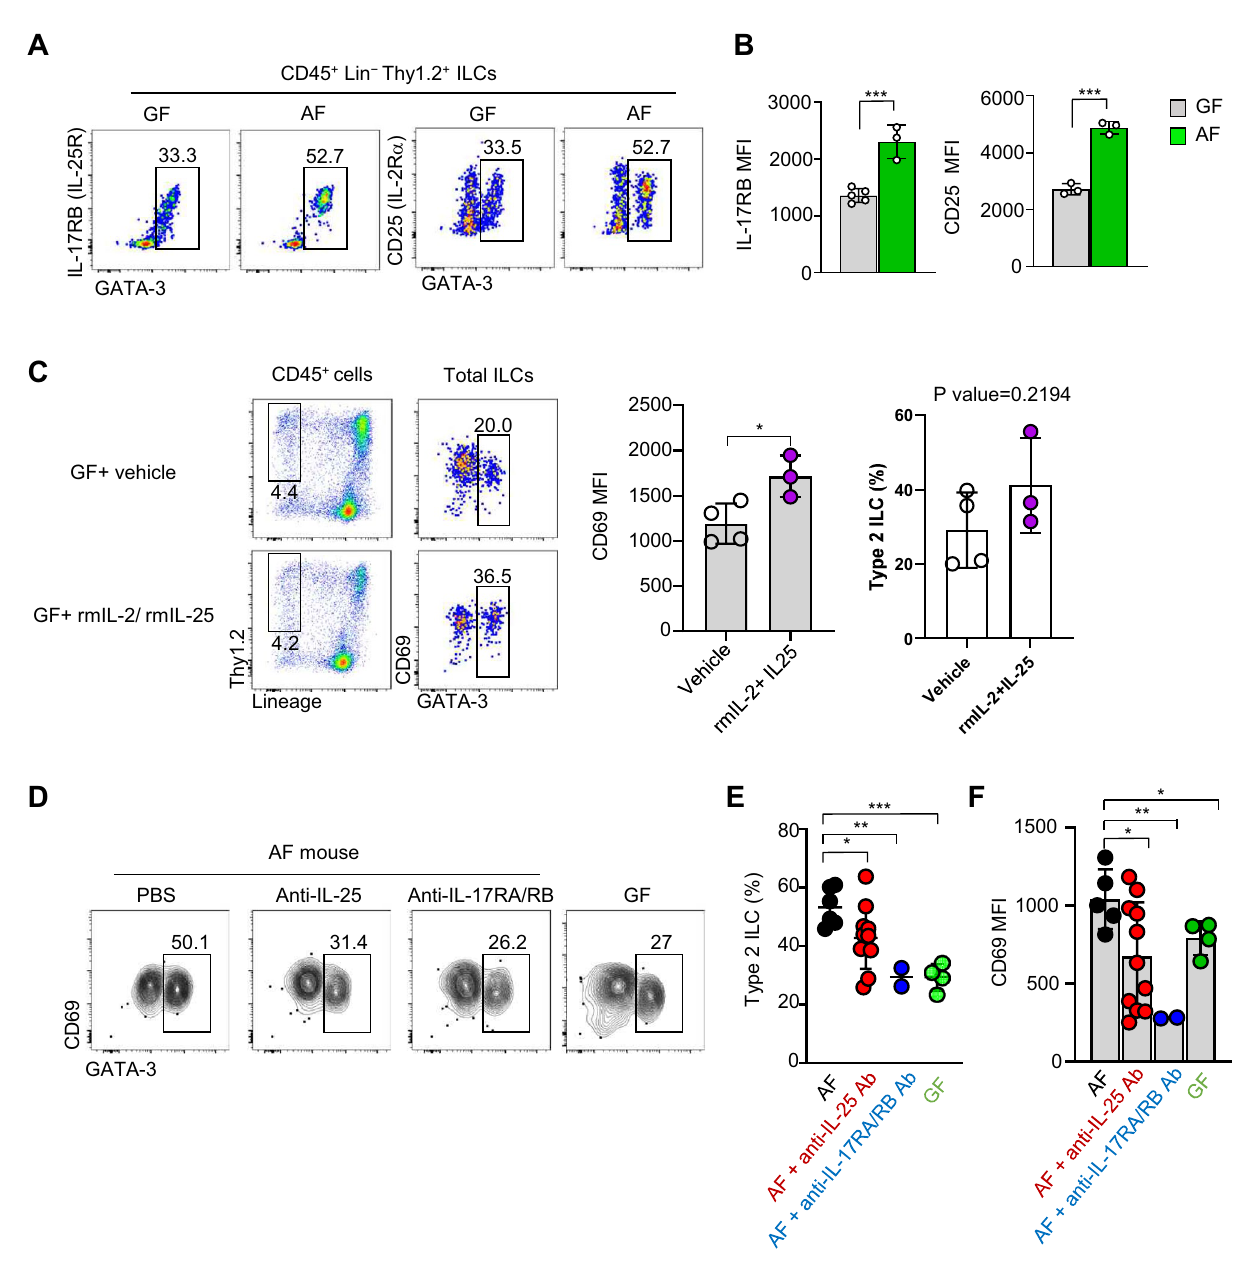
Figure 5. Expansion of ILC2s in AF mice is dependent on IL-25. Single-cell suspensions of the siLP mononuclear cells isolated from indicated mice were analyzed by flow cytometry. ( A and B ) Dot plots show IL-17RB and CD25 expressions in CD45 + Lin − Thy1.2 + cells in the indicated mice (A). Graphs show statistical analysis (N=3~5) (B). Data are representative of three independent experiments. ( C ) GF mice were administered with either PBS (vehicle) or recombinant mouse (rm) IL-25 plus IL-2 daily for three consecutive days. Dot plots show CD69, and Ki-67 expressions in ILC2s, and the graph shows statistical analysis of CD69 expressions. ( D – F ) Contour plots show frequencies of ILC2s and their CD69 expressions in AF mice administrated with 250µg anti-IL-25 or anti-IL-17RA/RB-blocking antibodies for five consecutive days (D). Graphs show statistical analysis of the frequencies of ILC2s (E) and CD69 MFIs (F). Results were pooled from 3 independent experiments (N=2~11). *p<0.05, **p<0.01. ***p<0.001. NS, not significant (unpaired two-tailed student t-test). GF, germ-free; AF, antigen free; Lin, Lineage; MFI, mean fluorescence with goblet cell hyperplasia resulting in more resistance to parasitic infections. However, at the same time, they become more vulnerable to bacterial infections due to the loss of ILC3s. In this mouse, tuft cells were not analyzed, and they did not test ILC2 extrinsic effects that might determine the phenotype of VAD as it causes systemic deficiency of vitamin A. In contrast, we used AF diets that supplied all necessary nutritional ingredi- ents, ruling out systemic side-effects caused by nutritional imbalance. Overall, these results show the dietary components affect ILC homeostasis.